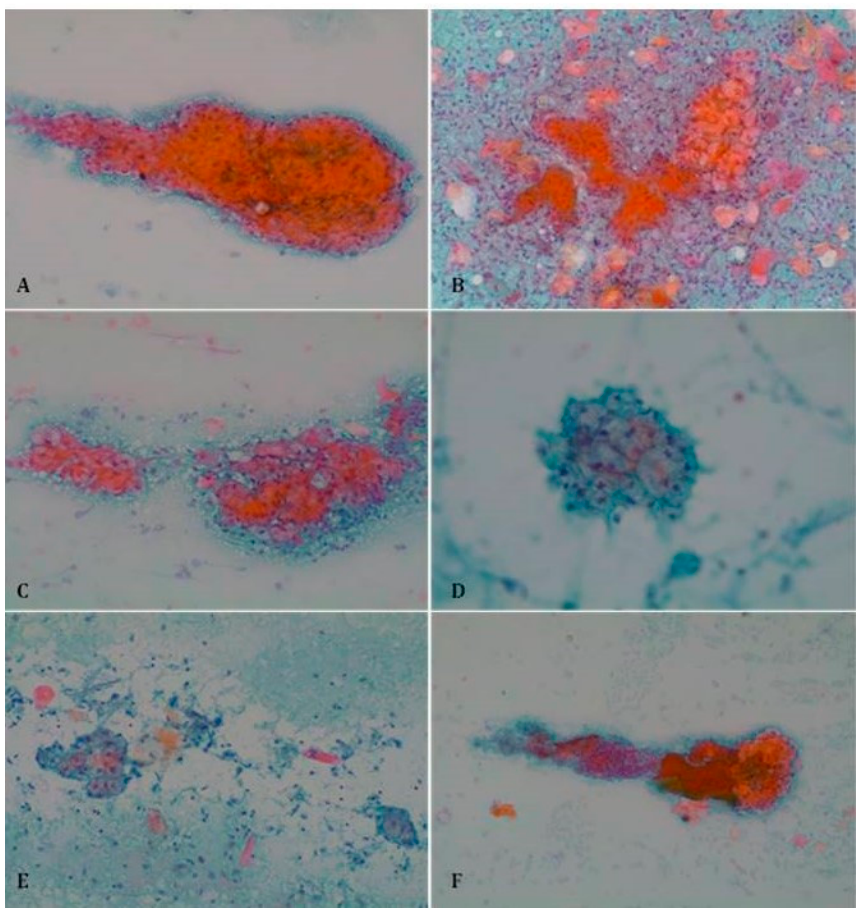
Figure 3. Clear sebaceous cells in sBCC (Papanicolaou stain). ( A ) Papanicolaou stain, ×100; ( B ) Papanicolaou stain, ×100; ( C ) Papanicolaou stain, ×100; ( D ) Papanicolaou stain, ×200; ( E ) Papanicolaou stain, ×100; ( F ) Papanicolaou stain, ×40.